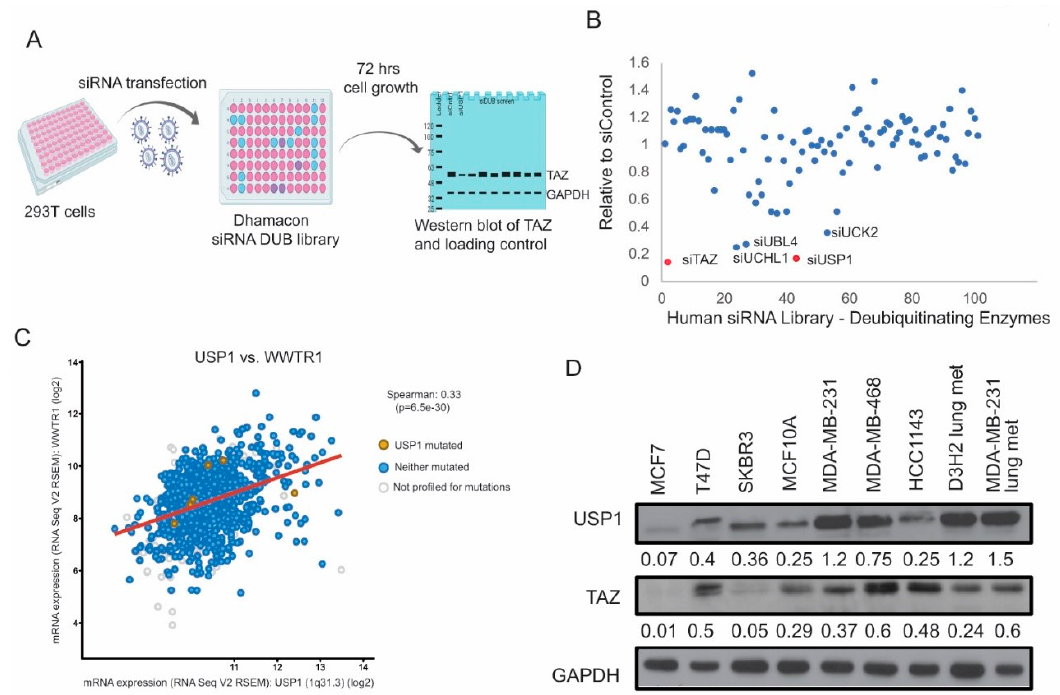
Figure 1. USP1 is a novel DUB of TAZ. ( A ) Schematic representation of siRNA screen using Dharmacon siRNA DUB library prepared using BioRender. Three siRNAs targeting a single DUB were transfected per well. ( B ) Dot plot quantification of relative TAZ expression upon transfection with siRNA library from immunoblots. ( C ) Spearman correlation plot of mRNA expression of WWTR1 vs. USP1 from TCGA data. ( D ) Immunoblot analysis of USP1 and TAZ expression in a panel of breast cancer cell lines (MCF7 and T47D – luminal, SKBR3 – HER2 overexpression, MCF10A –